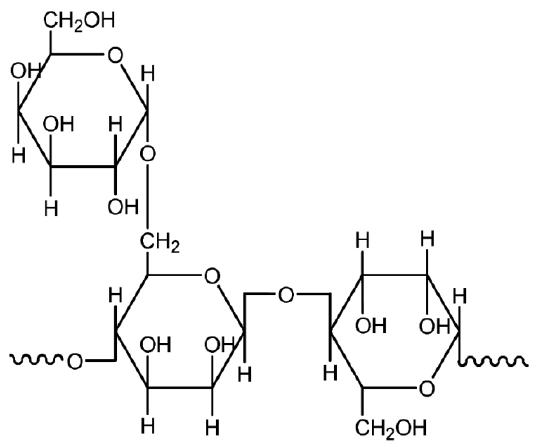
Figure 10. Representative unit of Guar gum.